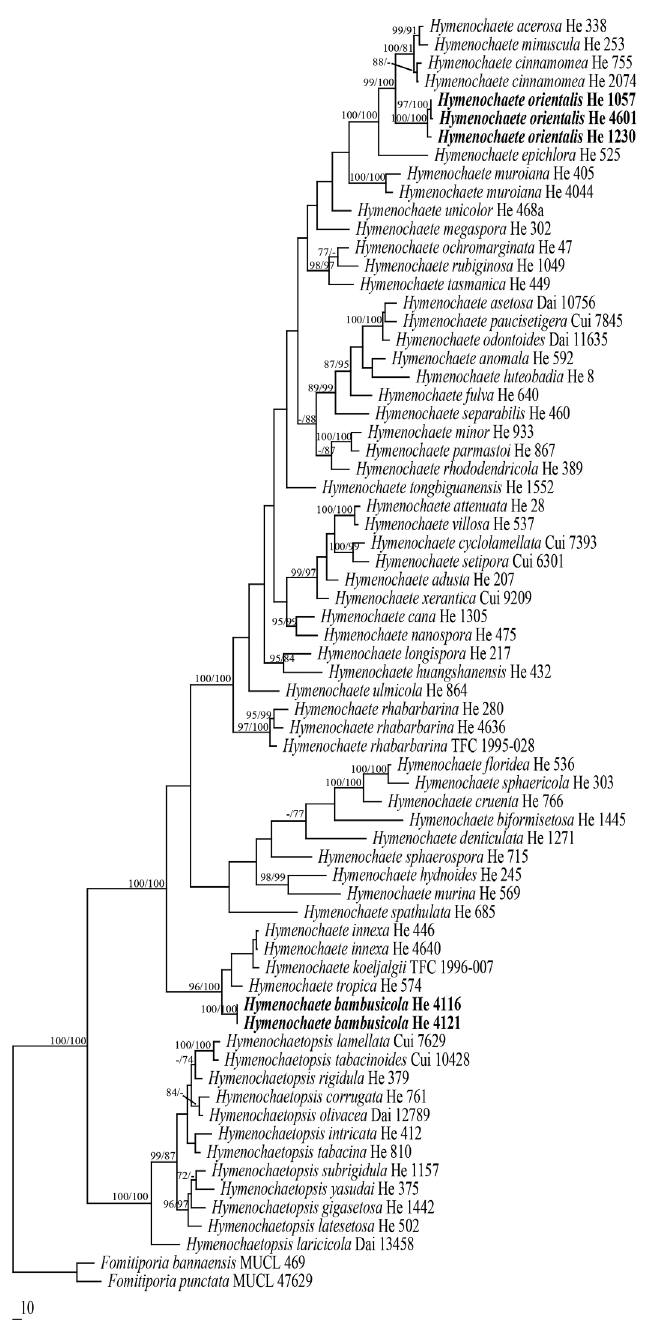
Figure 1. Strict consensus tree obtained from maximum parsimony analysis of combined ITS and nrLSU sequence data of taxa of Hymenochaete and Hymenochaetopsis . Branches are labeled with parsimony bootstrap (before slash) ≥ 70% and likelihood bootstrap (after slash) ≥